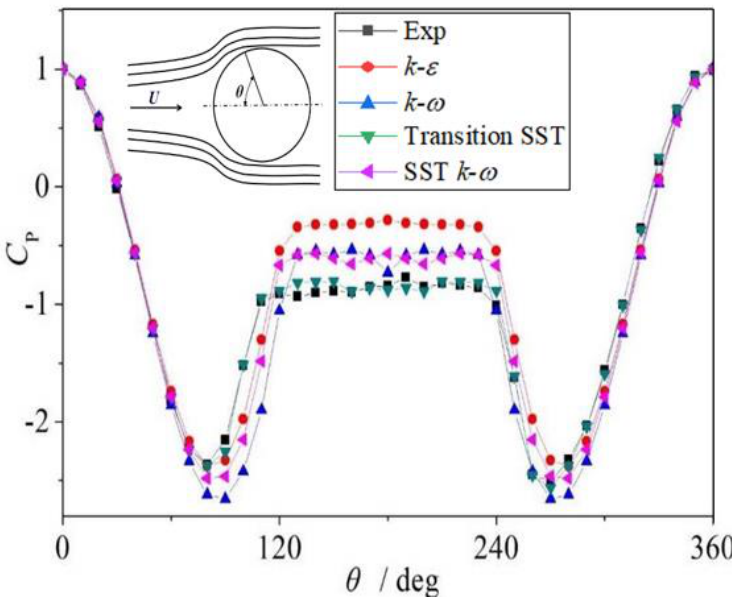
Figure 2. Comparison of the time − averaged pressure coefficient distribution on the tube. Table 1. Coefficient deviation under various turbulence models.